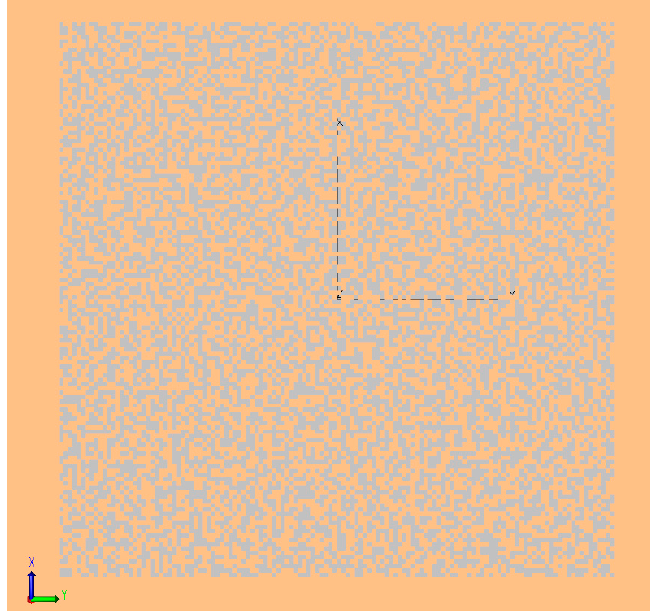
Figure 8. False color map of the random 128 × 128 coded aperture with the smallest aperture of 13 μ m. The mask was constructed using the “perfect absorber” property with geometric sizes of 1.664 × 1.664 mm.